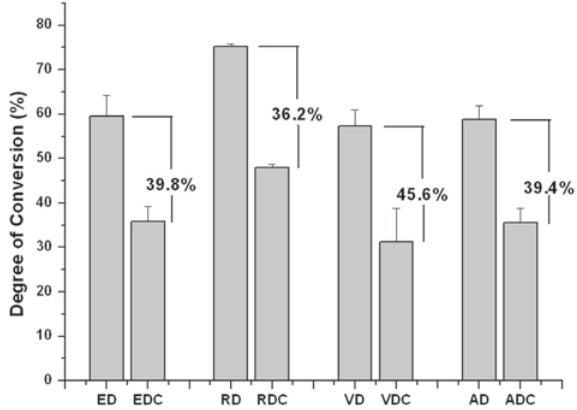
Means with same capital letter are not statistically different within the same line. Means with same lower case letter are not statistically different within the same column ( (cid:1) =0.05). Ch= chemical activation; DC= ceramic dick; D= dual activation. Statistical analysis Statistical analysis